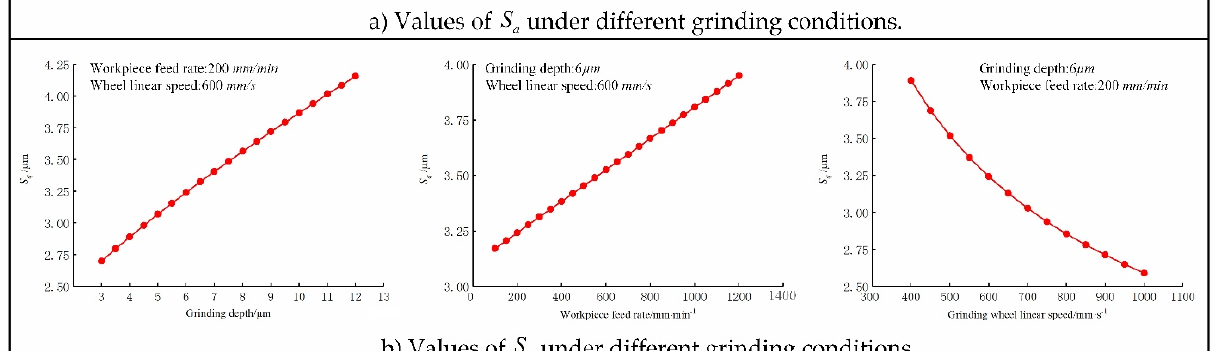
Figure 6. Values of a